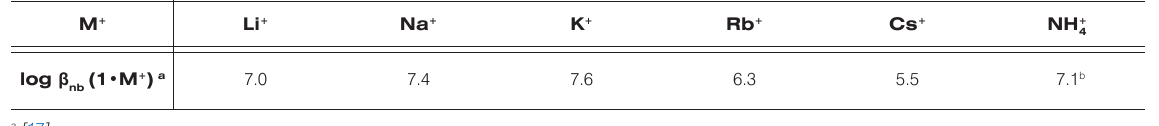
Table 2. Stability constants of the 1. M + complexes (1 = benzo-18-crown-6; M + = Li + , Na + , K + , Rb + , Cs + , ) in nitrobenzene saturated with water at